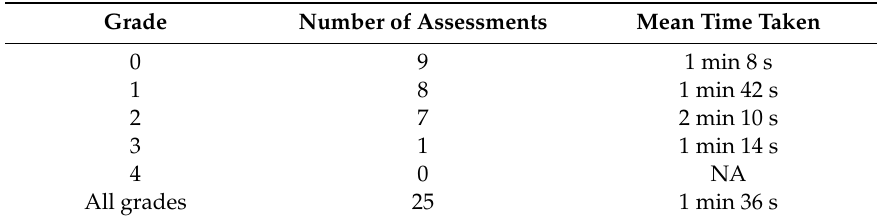
Table 2. Time taken for assessor to complete chemotherapy induced phlebitis severity (CIPS) scale (V8). Grade